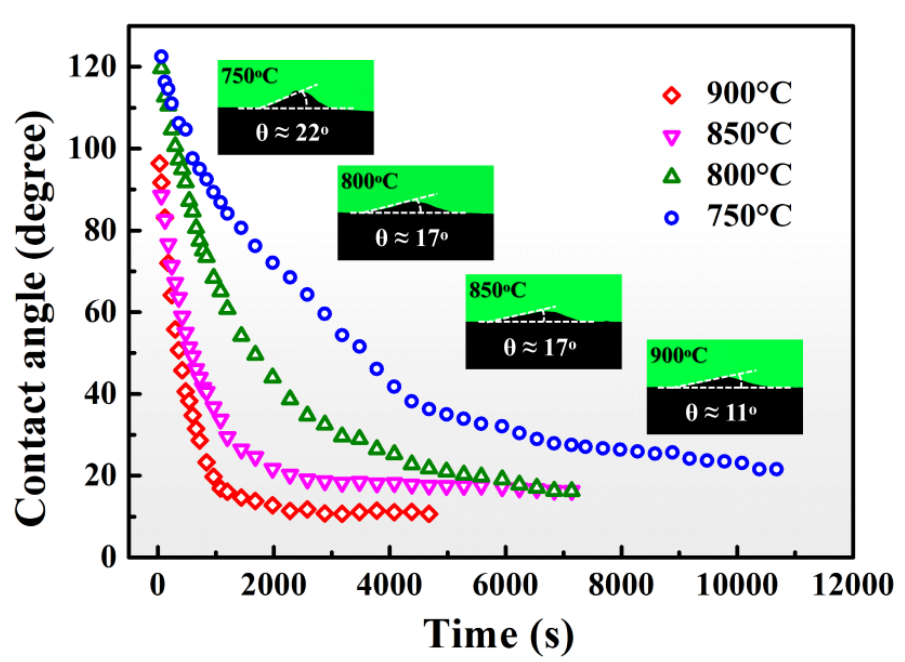
Figure 5. Time sequence of the apparent contact angles of the Sn-3V alloy on porous graphite isothermally wetting at 750, 800, 850, and 900 °C. The inserts correspond projective images of isothermally wetted samples.